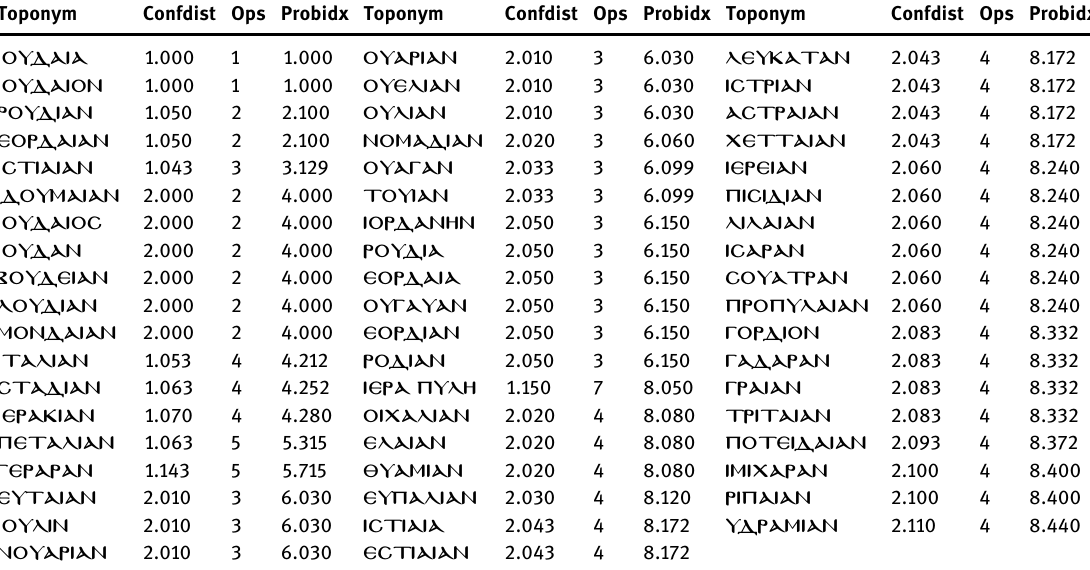
Table 3: Palaeographical close toponyms to IO ϒΔ AIAN Toponym